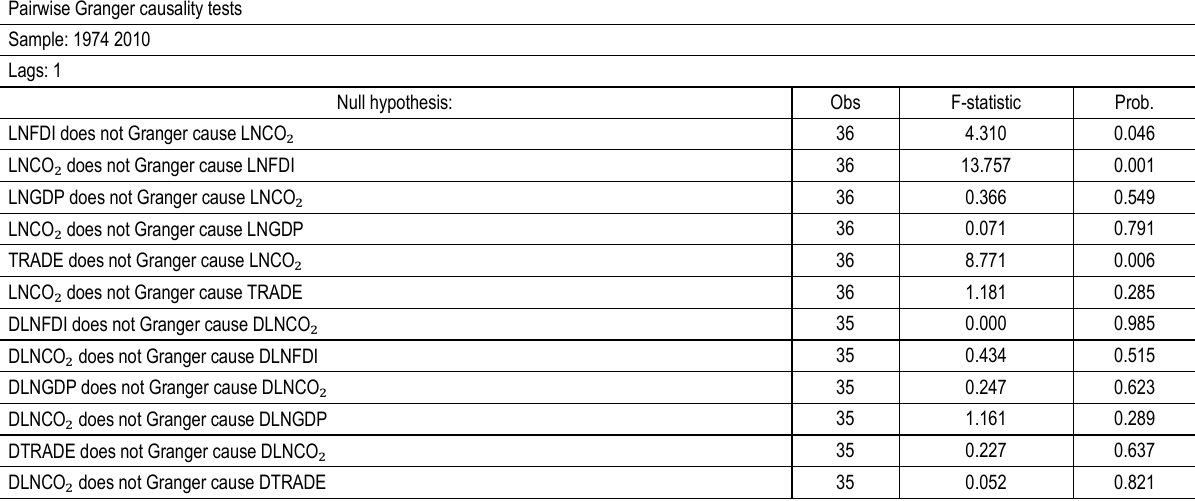
Table 5. Causality analysis test